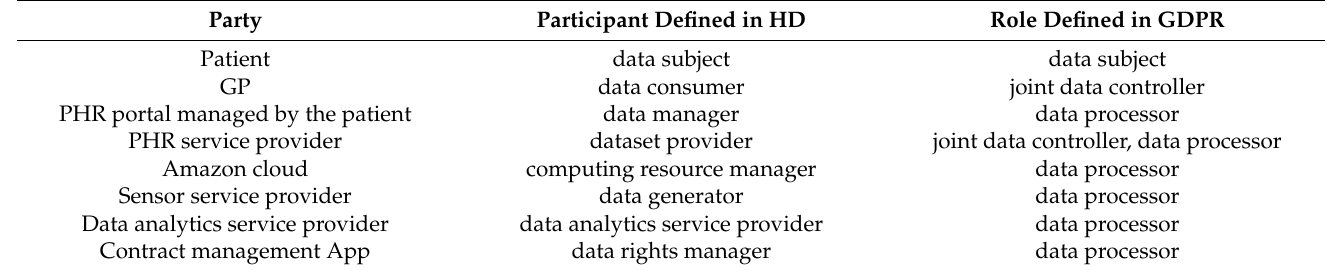
Table 1. A sample mapping between stakeholders defined above and the GDPR-defined